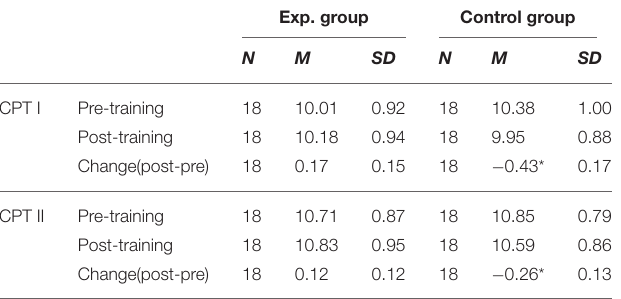
TABLE 2 | Mean and SD of pain tolerance in cold pressor tasks (Log e transformed).